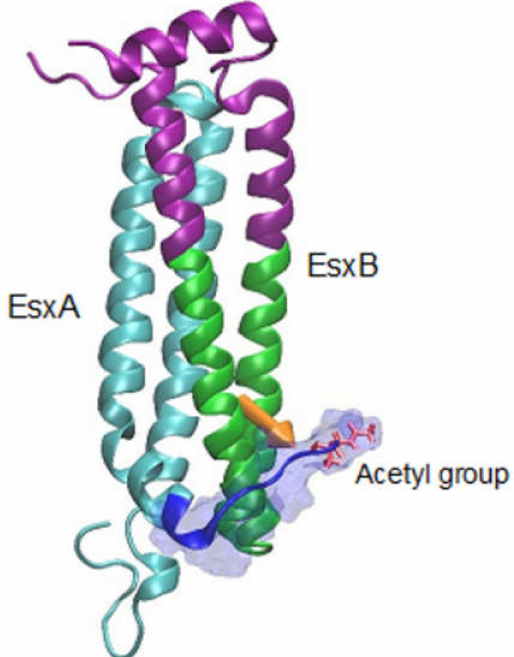
Figure 2. Interaction between the N α -acetylated EsxA and EsxB at pH 4. The structure of Mtb EsxAB heterodimer with N α -acetylation was analyzed by molecular dynamic simulation. The figure was generated from snapshots of 20 ns molecular dynamic (MD) simulations at pH 4. EsxA is colored in cyan; the N-terminus of EsxA is colored in blue and shown in transparent surface representation. The acetylated Thr-2 residue is shown in bond representation and colored in red. The residues in EsxB within 20 Å of the N-terminus of EsxA are colored in green, and the residues beyond 20 Å are shown in purple. The orange arrows represent the electrostatic interaction between two sets of residues: the residues in the N-terminus of EsxA (blue) and the residues in EsxB within 20 Å of the N-terminus of EsxA (green). The MD simulation shows that the acetylated N-terminal arm of EsxA makes direct contracts with EsxB in a frequent “bind-and-release” mode, which generates a force of 44 pN to pull EsxB away from EsxA. The figure is modified from